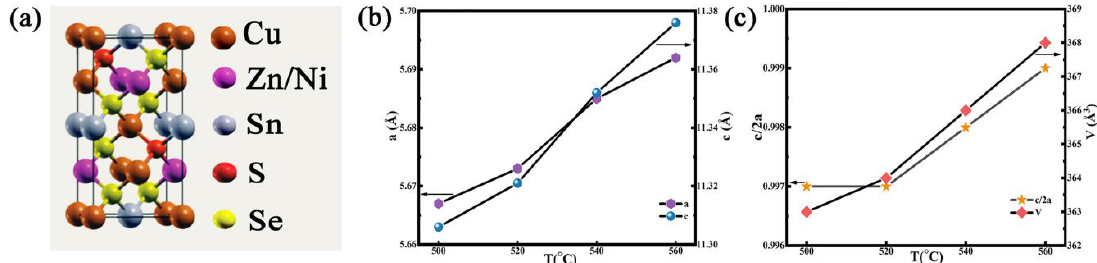
Figure 3. Curves of the 2 θ , peak intensity, and FWHM of (112) peaks for the CNZTSSe films as a function of selenization temperature.